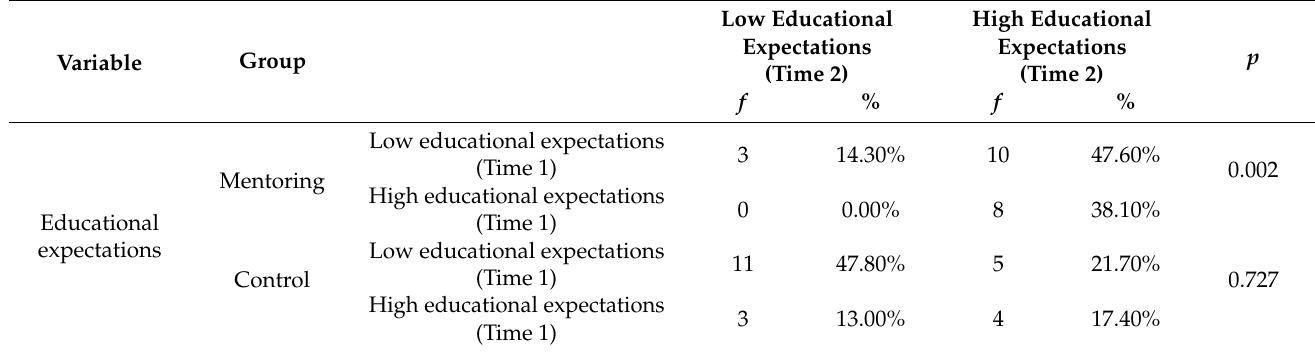
Table 4. Participation in the mentoring program and educational expectations: McNemar test.